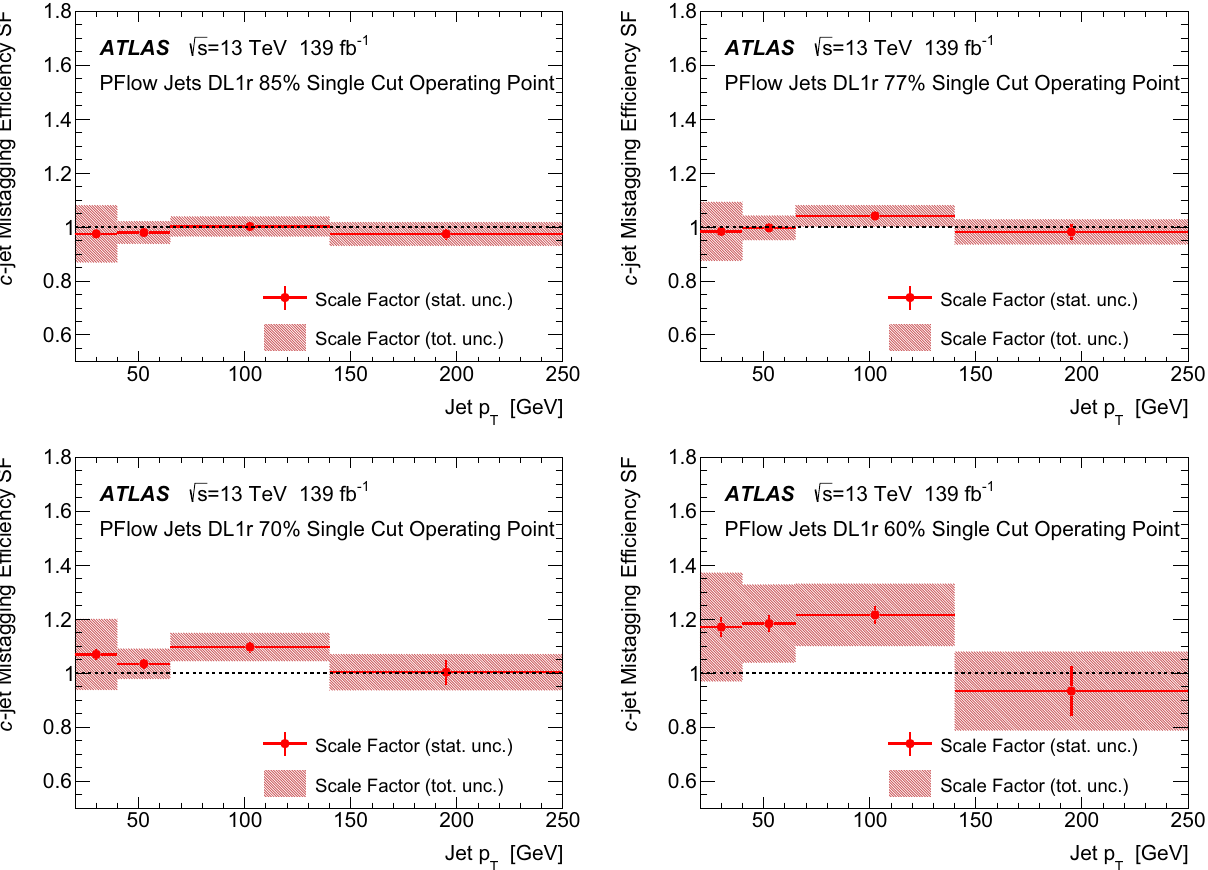
Fig. 6 The c -jet single-cut mistagging efficiency scale factors for particle-flow jets shown as a function of jet p T for the four tagging operating points. The scale factors are shown for the Pythia 8+ EvtGen fragmentation